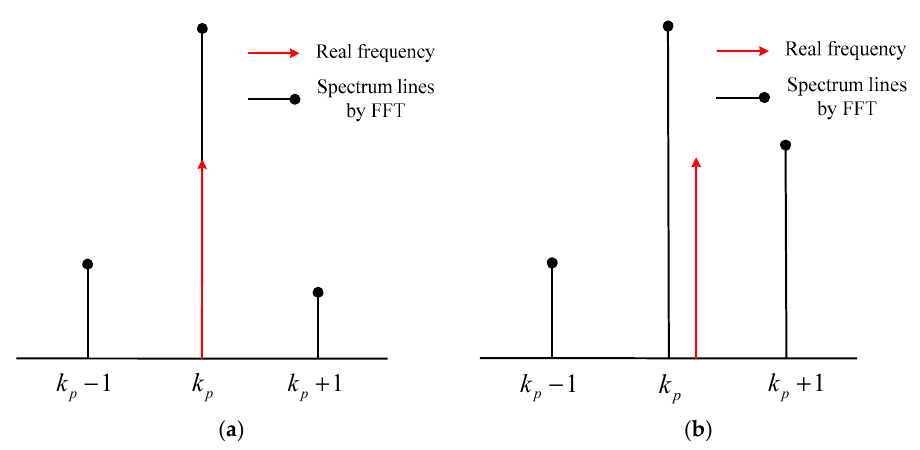
Figure 2. The relative position of the p th source frequency at the quantized frequency point: ( a ) Coincidence; ( b ) Mismatch.